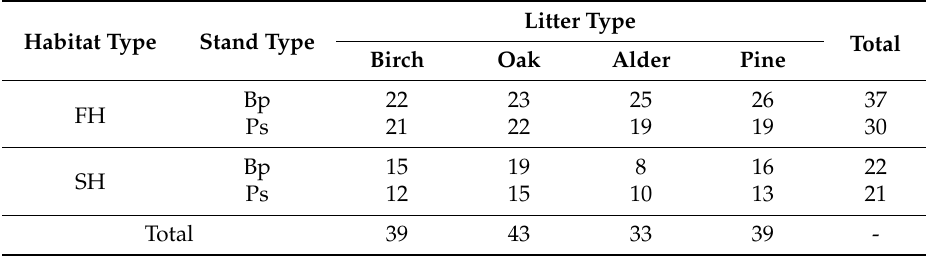
Table A3. Total number of mite species recorded in four types of litter in Betula pendula (Bp) and Pinus sylvestris (Ps) stands growing in forest habitat (FH) and spoil heap (SH). Habitat